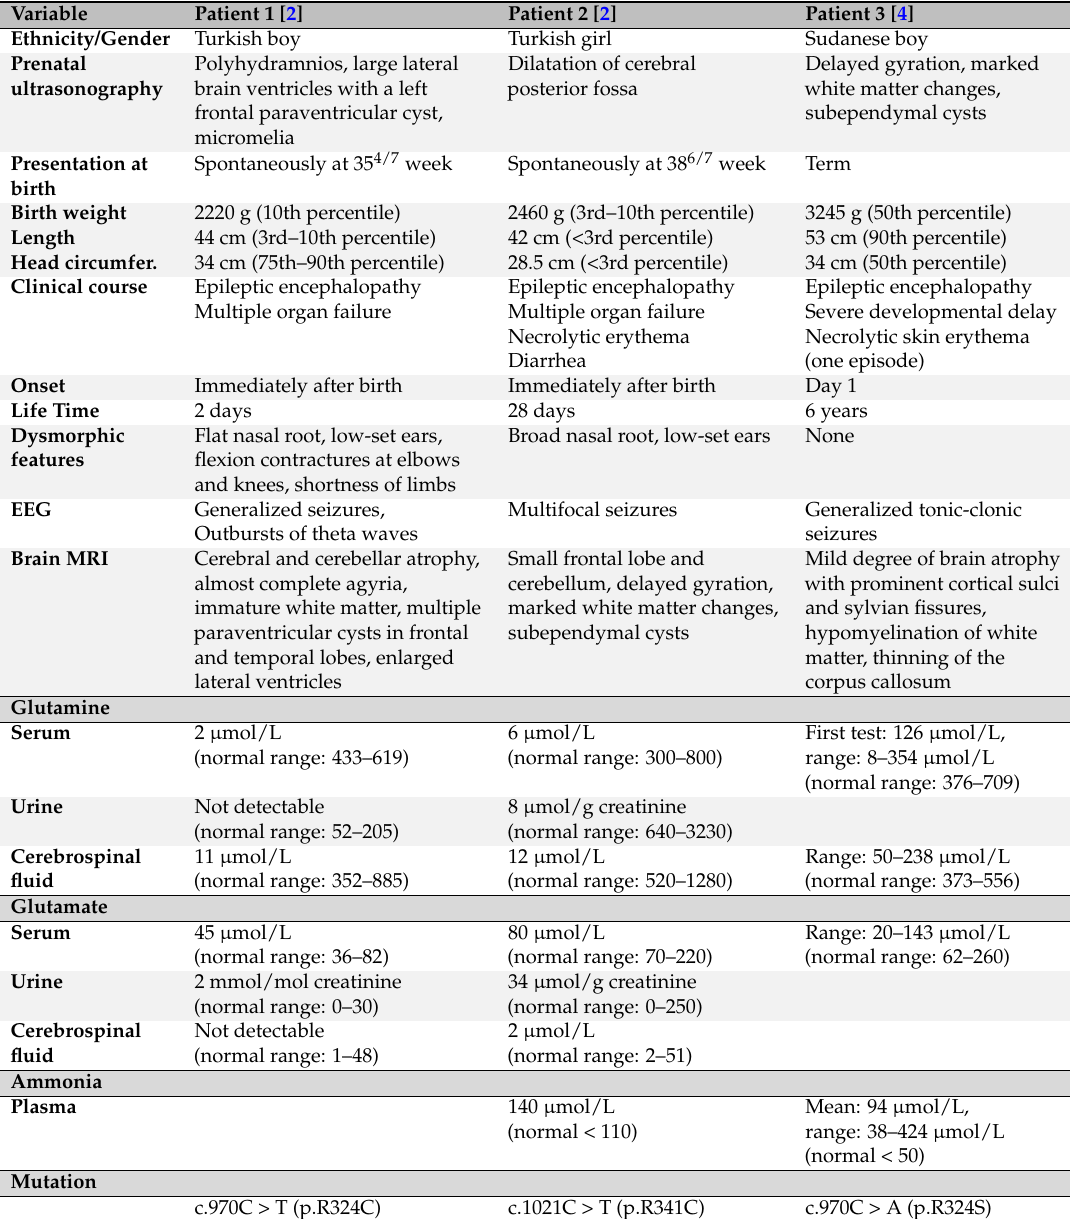
Table 1. Main clinical features and diagnostic analysis of patients with glutamine synthetase (GS)